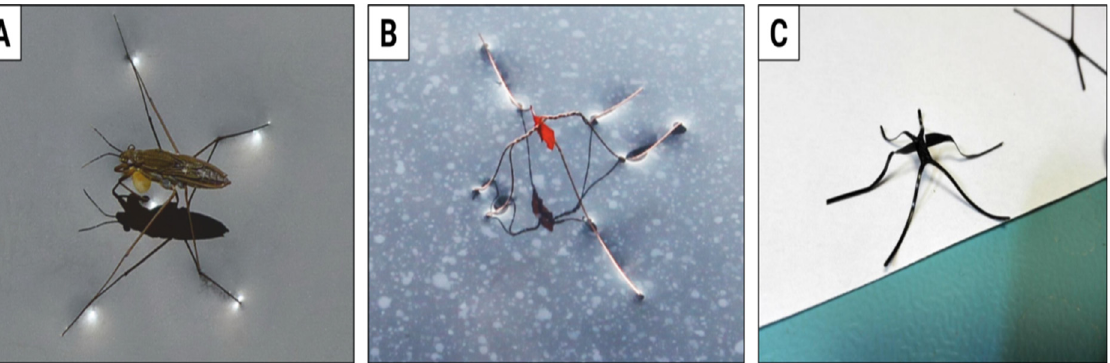
Figure 6. From the pond to the lab (and back)—a light-powered natural-scale water strider robot with LCE muscle. ( A ) Water striders are common inhabitants of reservoirs and rivers in many climate zones. ( B ) First prototype of the light-powered robo-strider with the orange LCE bending actuator powering a pair of legs. ( C ) The latest generation of the robot body (here without the actuator installed) was 2D printed with a 3D extrusion printer and then hot-shaped to take the final form. Water strider photo by Schnobby licensed under CC BY-SA 3.0.